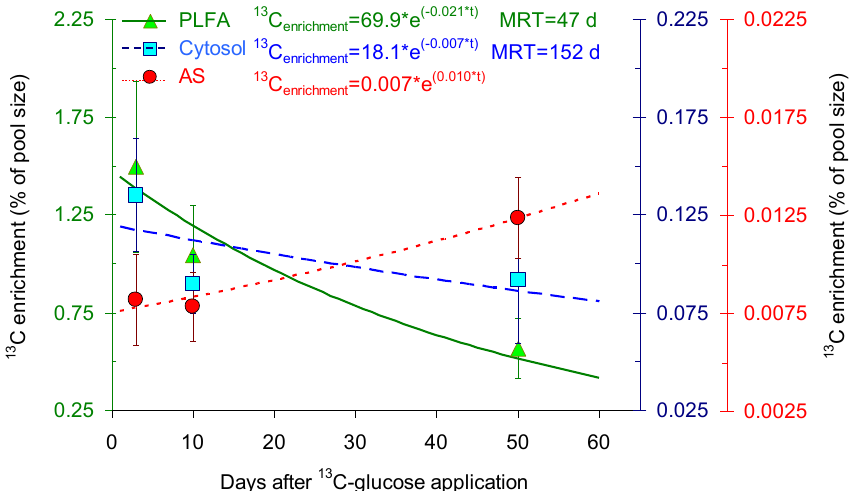
Figure 2. 13 C enrichment in the cytosol, PLFA and amino-sugar cell pools as well as functions to calculate the C turnover times in these microbial cell pools. The left y axis represents the PLFA pool, the first right y axis the cytosol, and the second y axis the amino-sugar pool. Data present mean ( n = 4) and bars present standard errors.